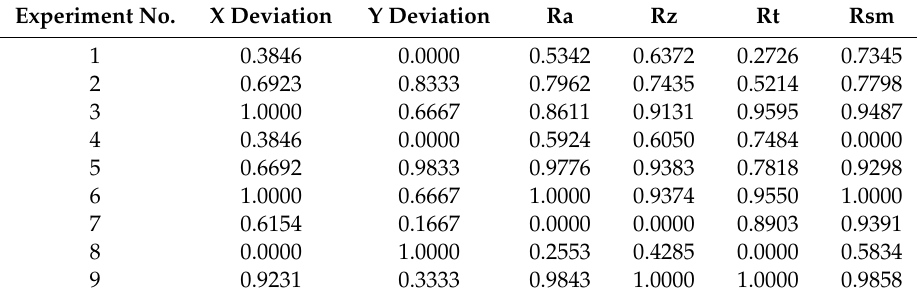
Table 10. Normalized quality responses.